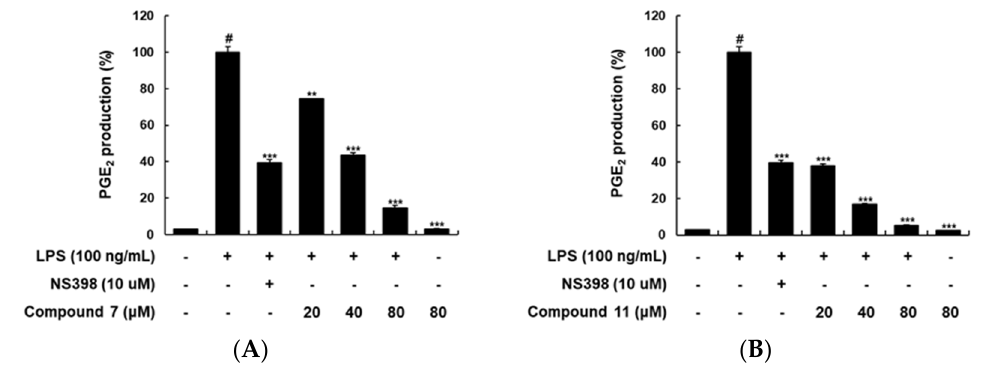
Figure 3. Inhibitory effects of compounds 7 ( A ) and 11 ( B ) on LPS-stimulated PGE 2 production in RAW 264.7 macrophages. Cells were pretreated with different concentrations (20, 40, or 80 μ M) of compounds 7 and 11 for 1 h, then with LPS (100 ng/mL), and incubated for 24 h. N-[2-(cyclohexyloxy)-4-nitrophenyl]-methanesulfonamide (NS-398, 10 μ M) was used as a positive PGE 2 production inhibitor. Level of PGE 2 in culture media was quantified using enzyme-linked immunosorbent assay (ELISA) kits. (#: p < 0.05 as compared with the untreated group, ** p < 0.05, and *** p <